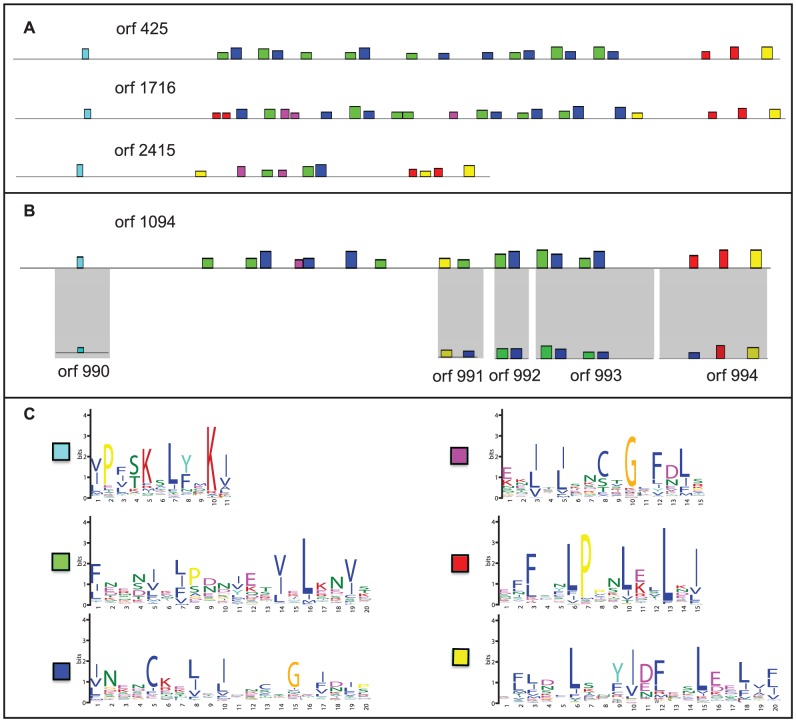
Characterization of a T. hominis-specific family of leucine-rich repeat (LRR) containing proteins.(A) Representative family members showing the characteristic pattern of LRR motifs. (B) Some shorter members of this family appear to be fragments derived from larger ORFs by pseudogenization, as indicated by patterns of sequence similarity and synteny. The height of the coloured boxes indicates the p-value of the motif hit assigned by the MEME suite [103]. (C) The LRR motifs that form the building blocks of this protein family, which, at 117 members, is the largest identified in the T. hominis genome.